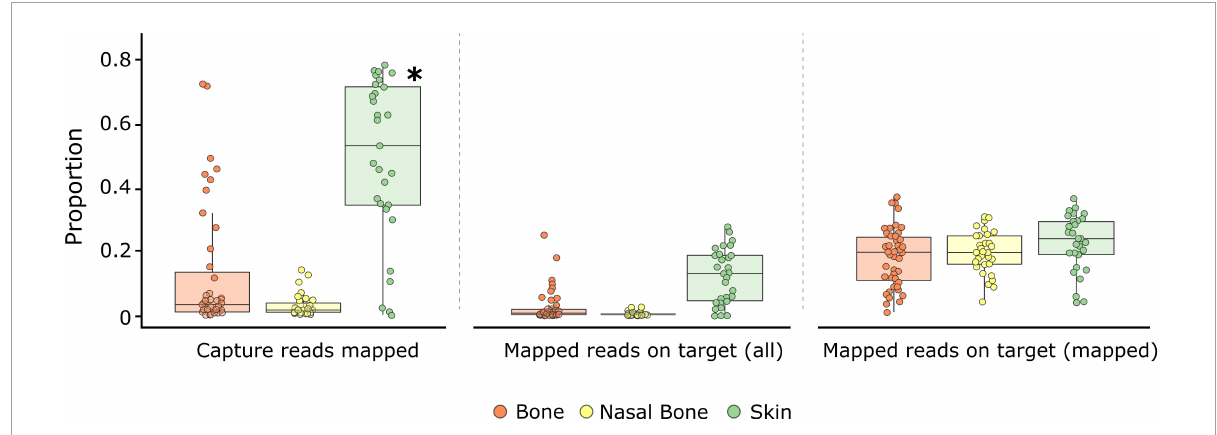
FIGURE2 Genomic metrics assessed from capture enrichment for each tissue type: bones (orange), maxilloturbinal (nasal) bones (yellow), and skins (green). Boxplots display the proportion of reads mapping after capture enrichment and reads mapping on target region in relation to all or mapped reads for each tissue. Within boxplots, dots represent historical samples, and the central line indicates the median value. Significant differences ( p < 0.05) between tissues for each metric are identified with an